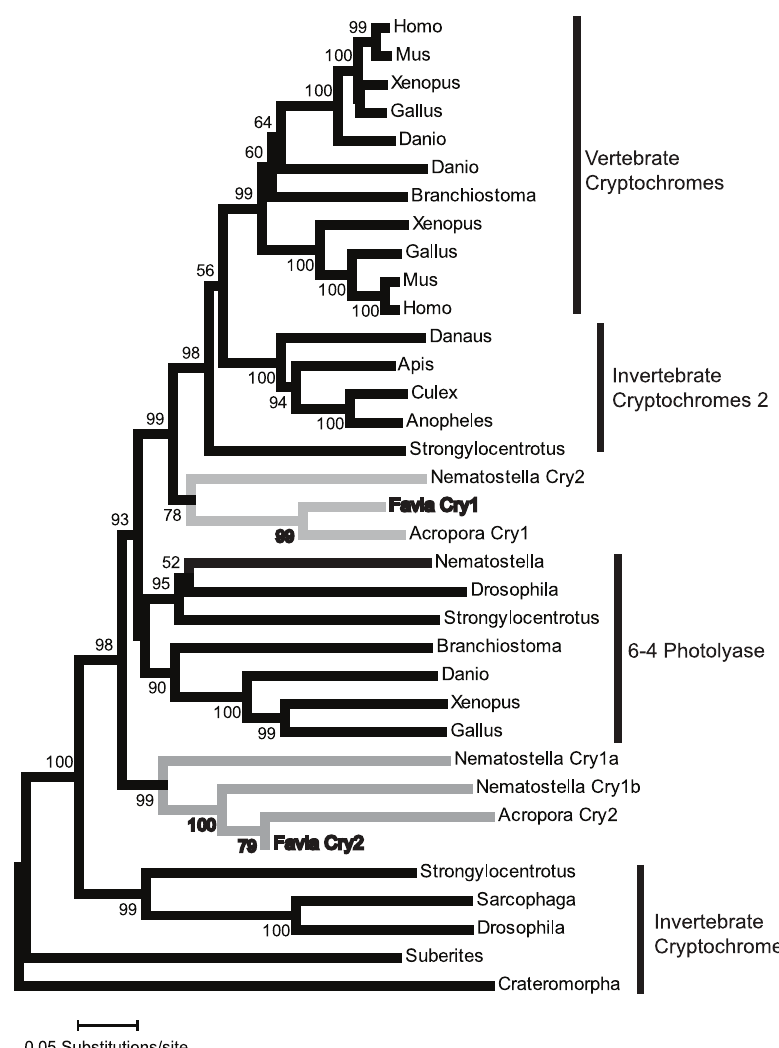
Figure 2. Phylogenetic relationship of F.fragum genes cry1 and cry2. Tree depicts a consensus of 1000 bootstrap replicates using the Neighbor-Joining method with pairwise deletions and Poisson control. Analyses with 1000 bootstrap replicates under Dayhoff or JTT models were also run and resulted in similar phylogenetic relationships (data not shown). Gray lines represent cnidarian lineages.